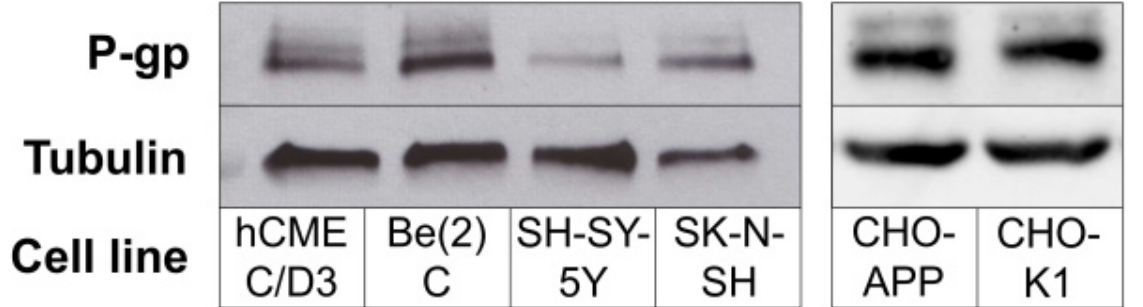
Figure 3. P-gp protein expression in cells. ( Left panel ) Cell lysates obtained from hCMEC/D3 and human neuroblastoma lines Be(2)C, SH-SY-5Y and SK-N-SH were analysed for P-gp protein expression (~170 kDa) via Western blot. ( Right panel ) P-gp expression in the non-neuronal CHO-APP cell line and its parental cell line CHO-K1. Tubulin (~50 kDa) was used as the positive loading control.